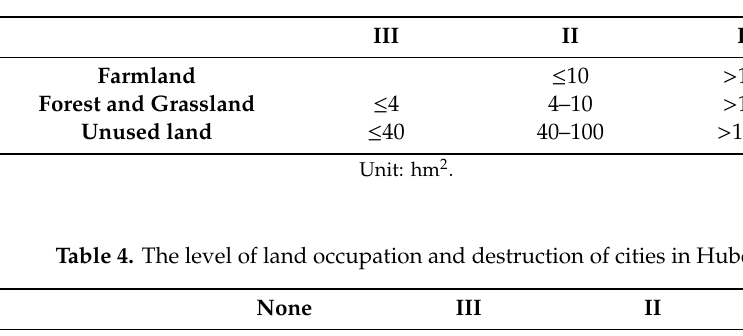
Table 3. The scale of land occupation and destruction evaluation.